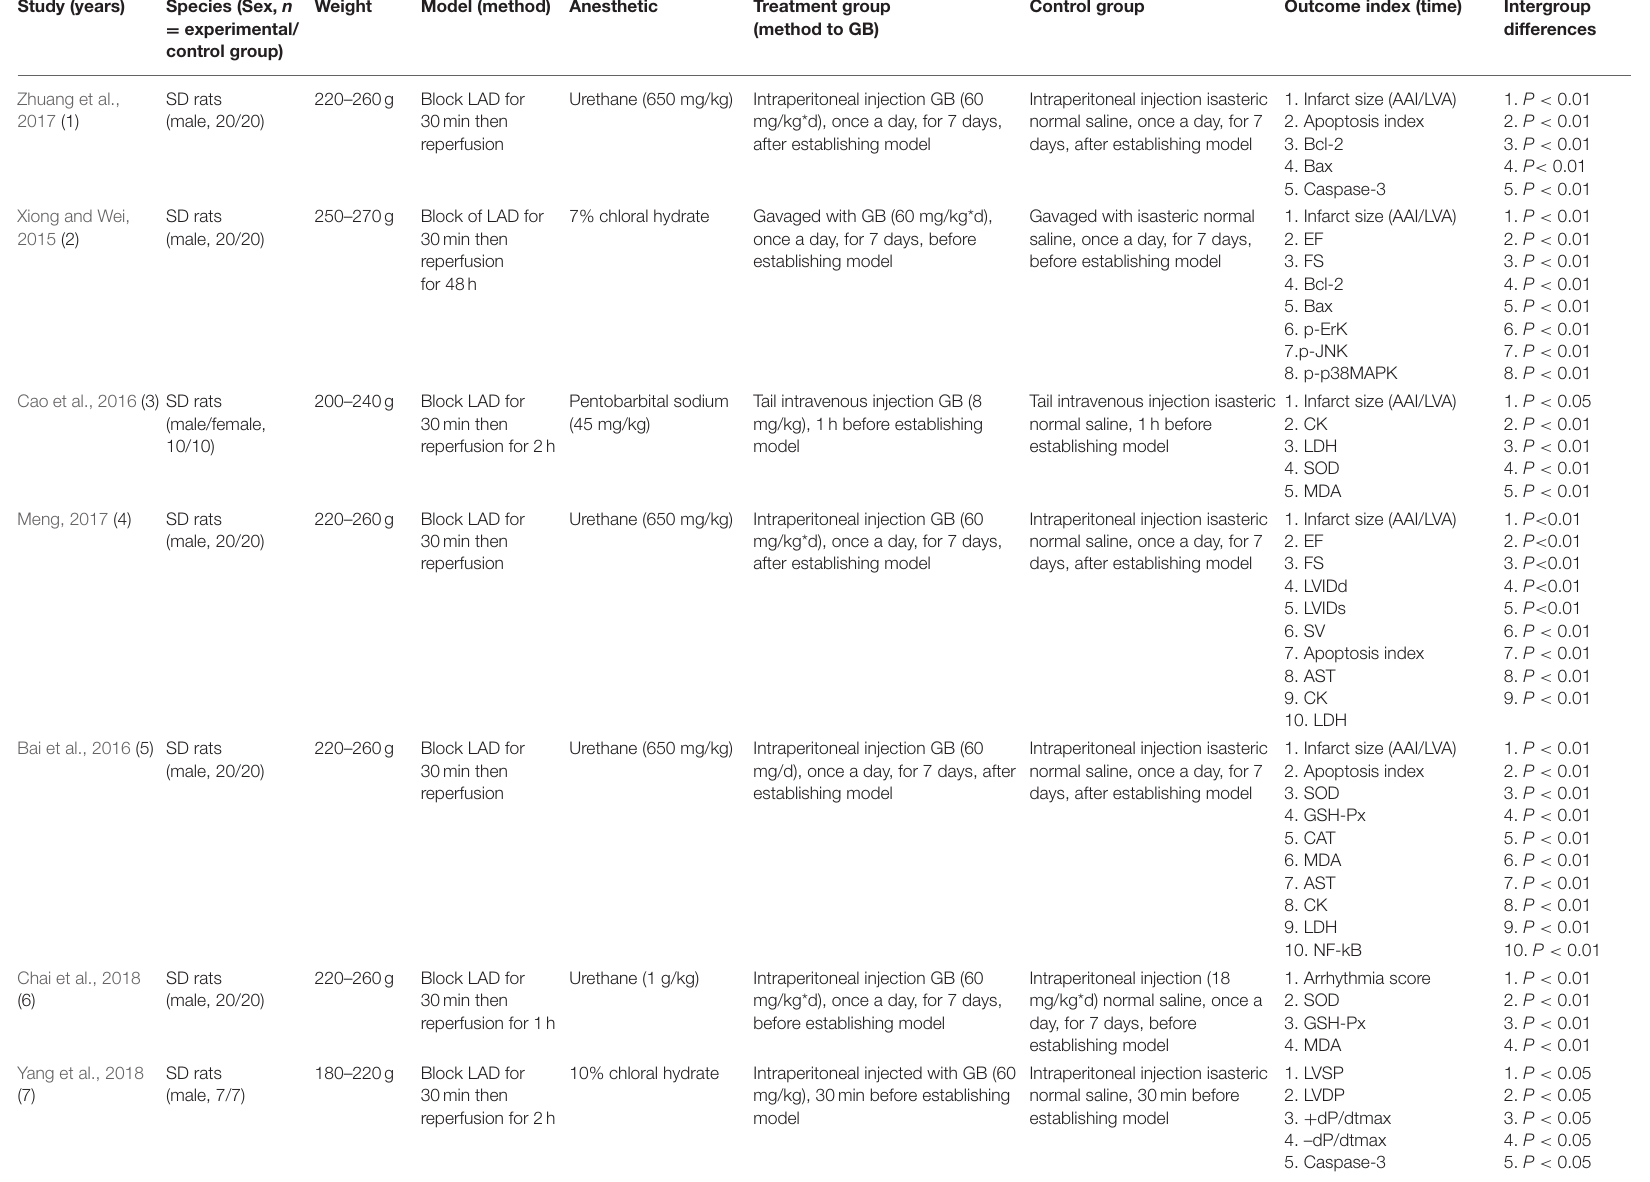
TABLE 1 | Characteristics of the 19 included